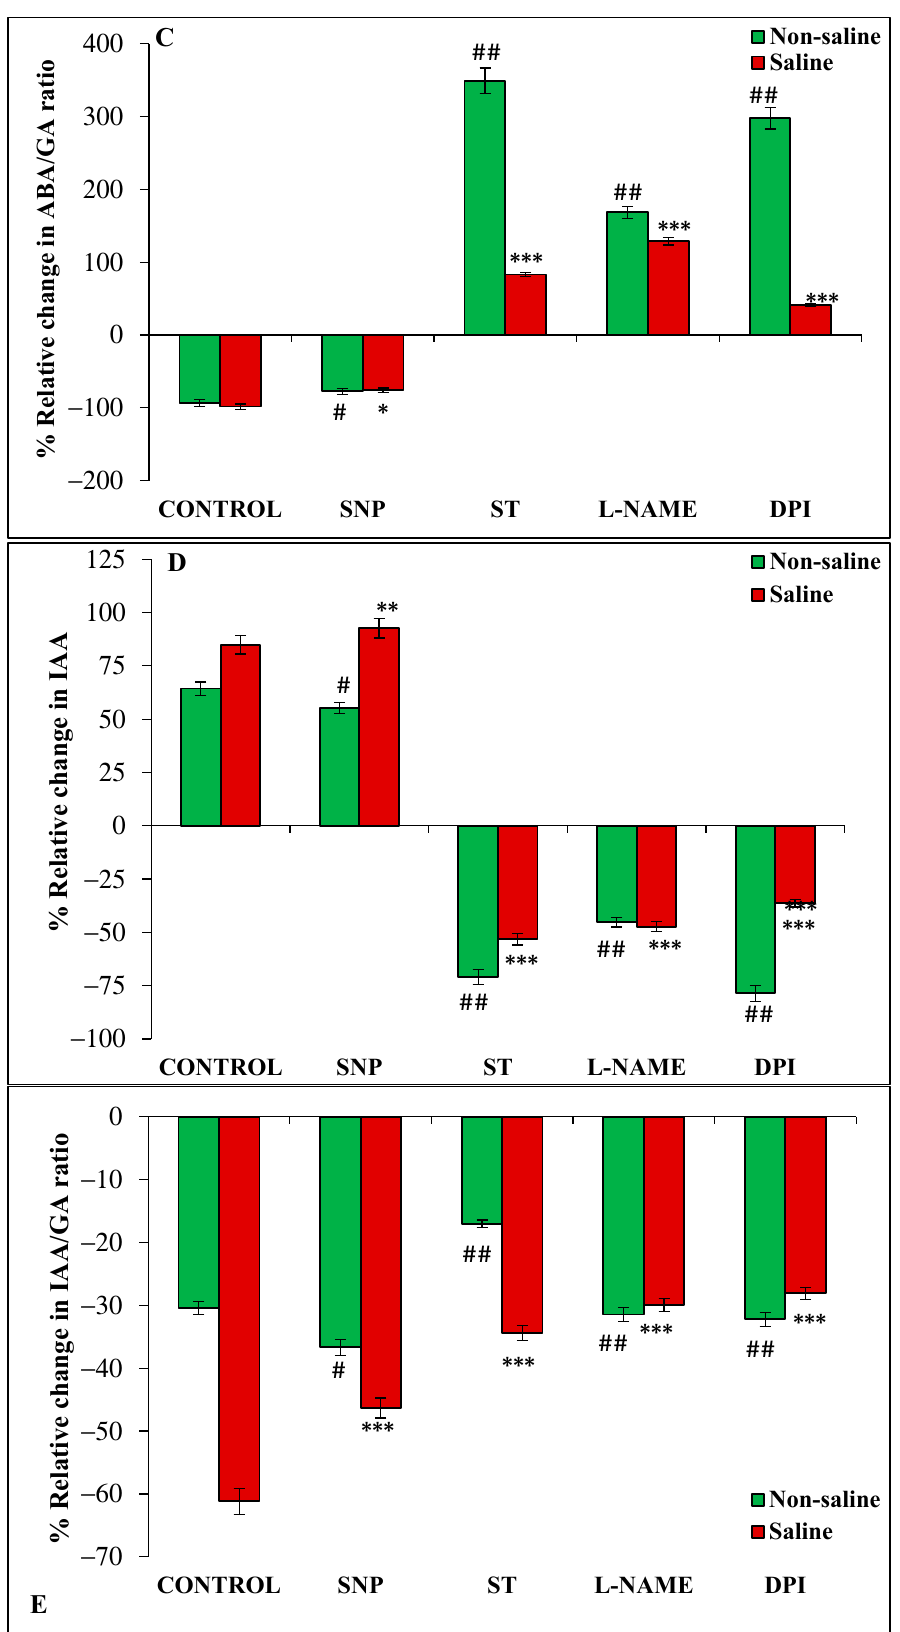
Figure 3. Relative change (%) in ABA ( A ), GA ( B ), ABA/GA ( C ), IAA ( D ) and IAA/GA ( E ) of magnetoprimed over unprimed seeds kept for 24 h in different modulators of NO and ROS production